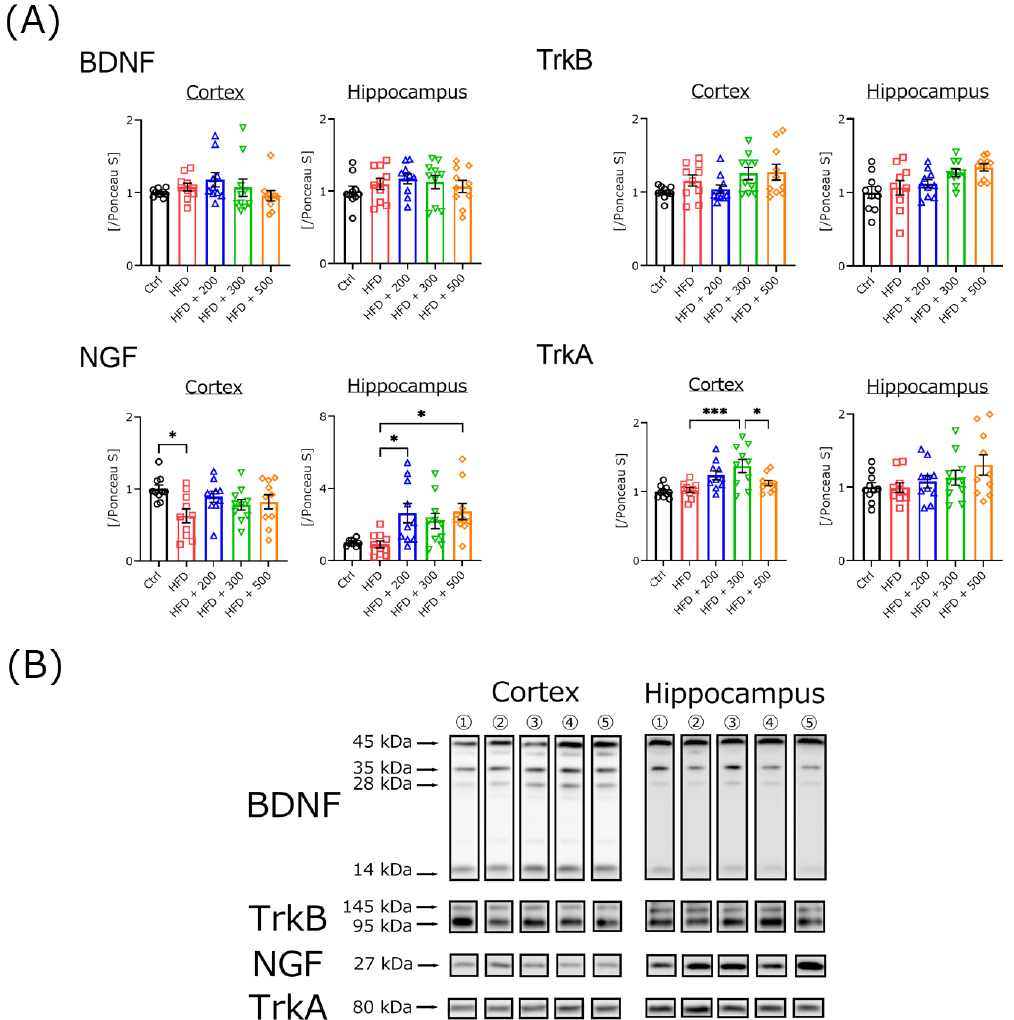
Figure 4. Western blotting analysis of the levels of neurotrophic factor-related proteins in the brains of control, HFD-treated, and HFD plus DSW-extract-added water-treated mice. All experiments were performed using cortex and hippocampal regions. The ratio of each protein band intensity to Ponceau S intensity is shown, with ratios of control samples set to 1 ( A ). Control (Ctrl, n = 10), high- fat diet (HFD, n = 10), HFD + DSW-extract-added water hardness 200 (HFD + 200, n = 10), HFD + DSW-extract-added water hardness-300 (HFD + 300, n = 10), HFD + DSW-extract-added water hardness 500 (HFD + 500, n = 10). * p < 0.05, *** p < 0.001. The data are shown as means ± SE. Comparisons were performed using the Tukey-Kramer method. Representative western blotting images ( B ).